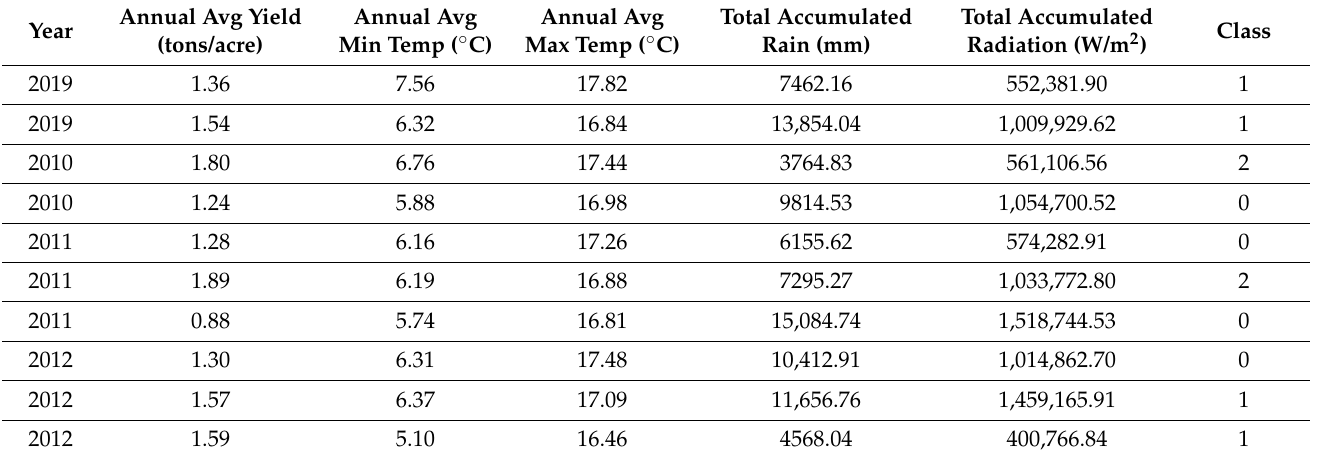
Table 2. Shows the four features used to train all SD and OH models plus year harvested and class, assigned according to standard deviation and yield; these are the 10 records in one very small OH target